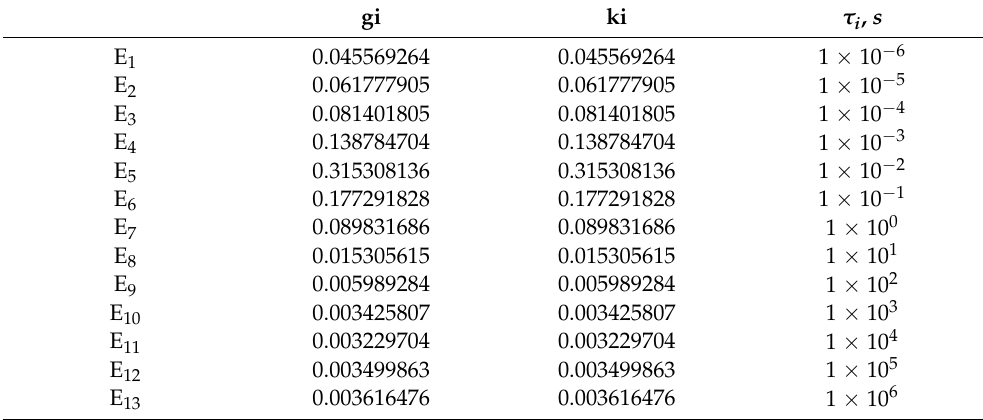
Table 3. Prony series for viscoelastic material definition (pavement temperature 21.1 ◦ C (70 ◦ F)) [45].